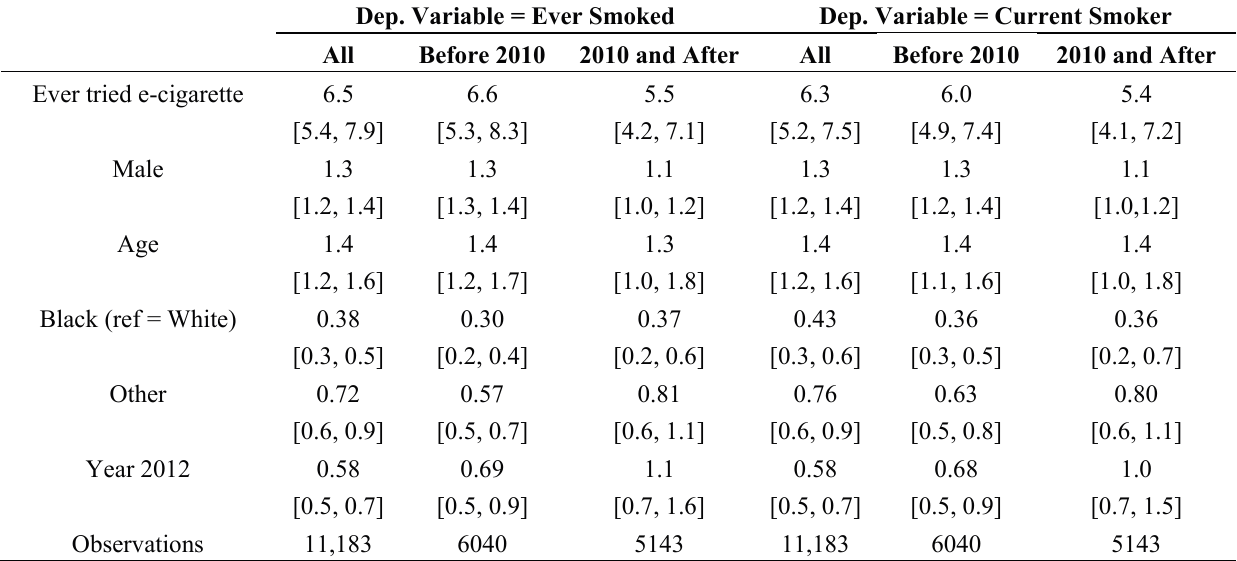
Table 6. Association of smoking and e-cigarette ever trying, by time of first trying a cigarette: before 2010 vs. later (ORs and 95% CIs).